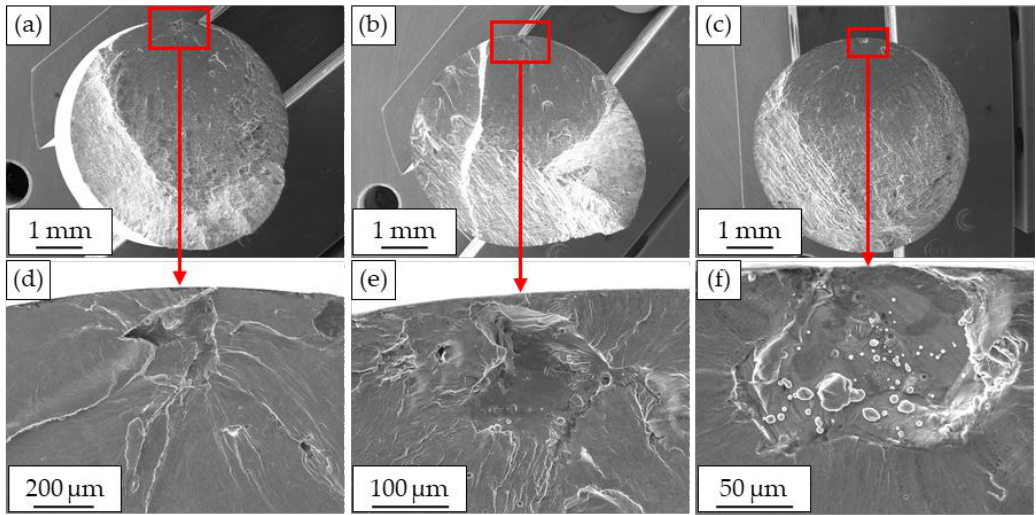
Figure 11. Fractographic analysis after fatigue tests in scanning electron microscope: ( a ) and ( d ) 0°-specimen; ( b ) and ( e ) 45°-specimen; ( c ) and ( f ) 90°-specimen.